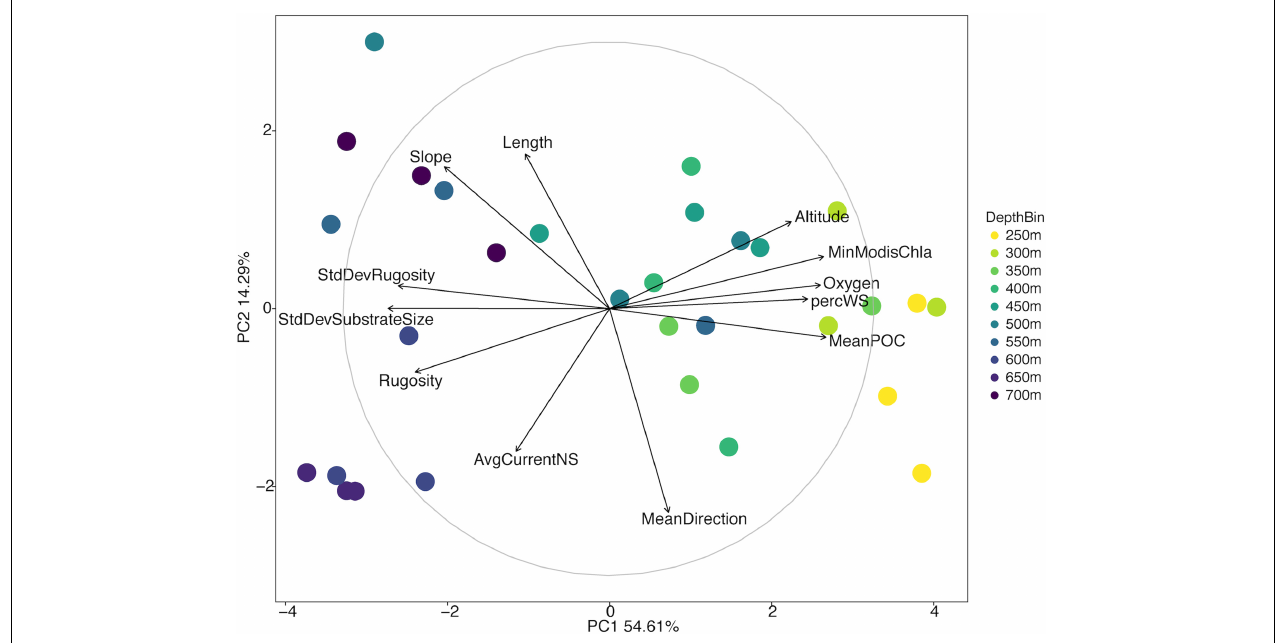
FIGURE 2 | Principal components analysis diagram of environmental variables of the North side of Mokumanamana. Each point represents a single 1 km transect coded by depth.